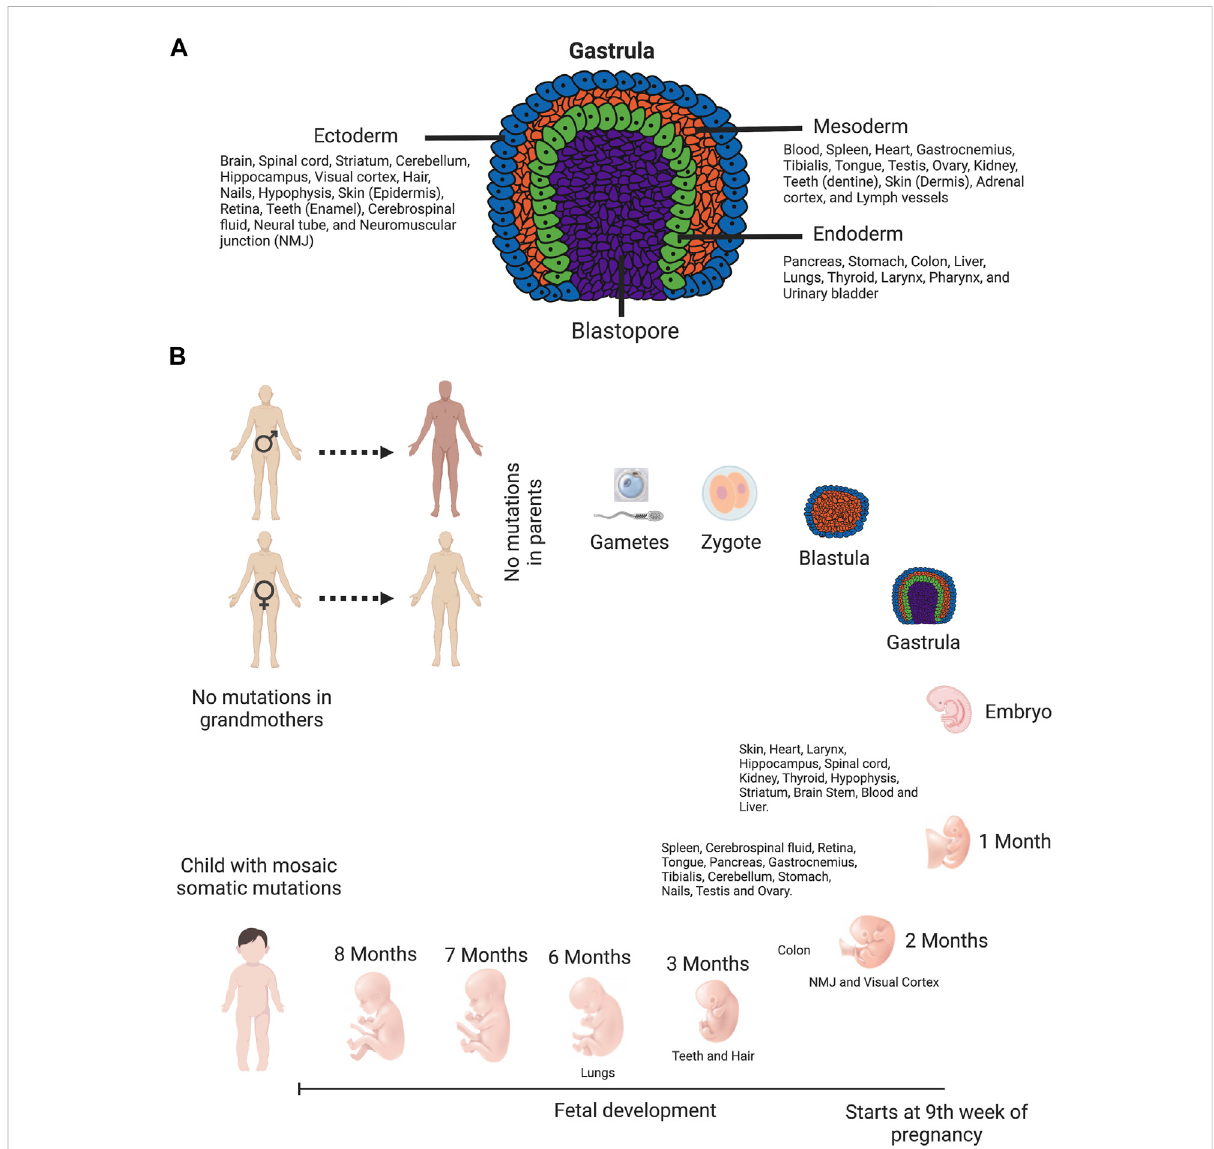
FIGURE 4 Timing of de novo mutations: they can happen anytime. (A) Diagram of gastrula — the embryo with three primary germ layers (ectoderm, mesoderm, and endoderm). This diagram is color-coded: ectoderm, blue; mesoderm, orange; endoderm, green; and blastopore, purple. Cells in ectoderm, mesoderm and endoderm differentiate into tissues and embryonic organs. The ectoderm contributes to the nervous system and the epidermis,amongothertissues.Themesodermcontributestothemusclecellsandconnectivetissueinthebody.Theendodermcontributesto the gut and many internal organs (Pansky, 1982). (B) Human timeline of development features and approximate developmental timing of various tissues. Tissues are arranged depending on the approximate time of development. The single-cell zygote, which proceeds through cleavage divisions and the morula stage to form the blastocyst, is arose by the fertilization of a mature oocyte by a sperm cell. The embryo is originated from theinnercellmassoftheblastocyst. Duringtheprocessofgastrulation,thesecellsdifferentiatetoformthethreegermlayers(ectoderm,endoderm, and mesoderm), which differentiate into tissues and embryonic organs. Following birth and sexual maturation, mature sperm and oocytes are produced by the completion of meiosis in adult animals. Schematics prepared using bio-render